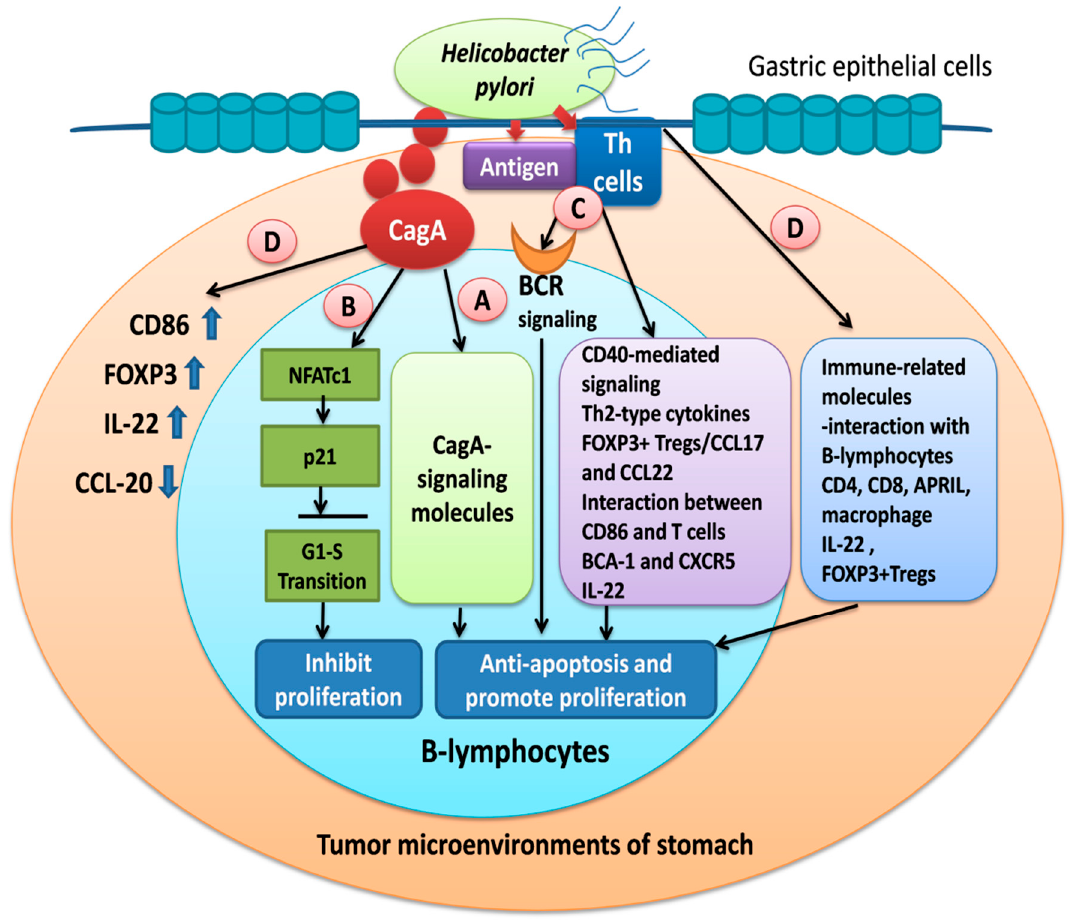
Figure 2. Involvement of ctotoxin-associated gene (CagA)-derived signals, T-cell-derived signals, and tumor microenvironment-related mediators in the Helicobacter pylori (HP)-induced lymphomagenesis of gastric mucosa-associated lymphoid tissue (MALT) lymphoma. HP infection stimulates T lymphocytes and cytokines in the gastric mucosa and indirectly induces the development of MALT, from which